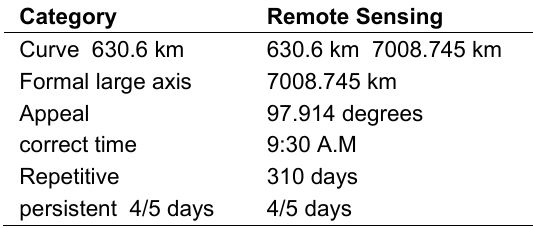
Table 1. Stipulation of Cartosat-2 Satellite Data